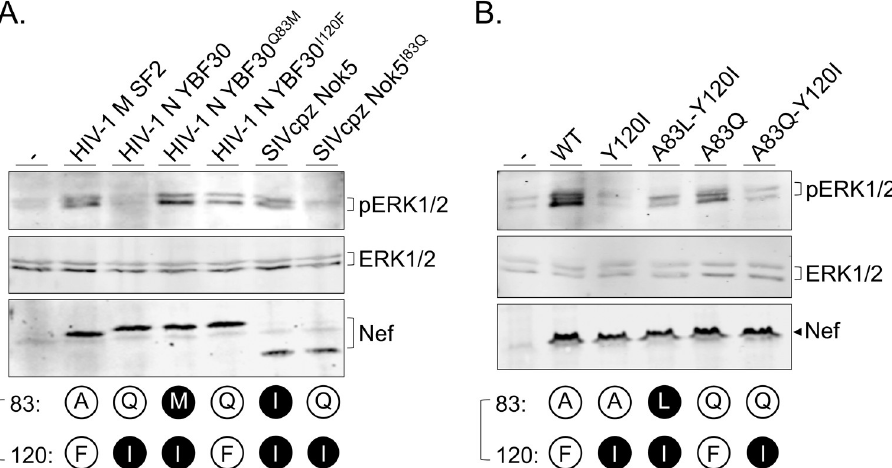
Fig 8. Role of the R-clamp in activation of in vitro differentiated macrophages by Nef. The indicated wild-type or mutant Nef proteins from HIV-1 M (panels A. and B.), HIV 1 N (panel A.), or SIVcpz(P.t.s) (panel A.) were expressed via lentiviral transduction in M1-like macrophages differentiated from THP-1 cells, followed by Western blotting analysis to compare the expression of Nef, total ERK1/2, and phosphorylated ERK1/2 in these cells or control macrophages transduced with an empty lentivector